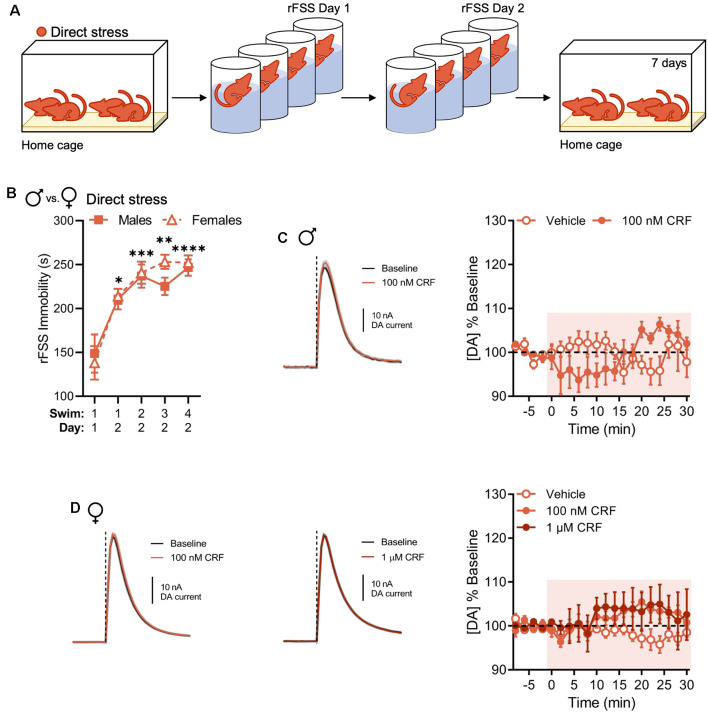
Direct stress disrupts CRF-mediated dopamine release in the NAc 1 week after repeated forced swim stress (rFSS) exposure in males and females. (A) In the direct stress experimental group, mice were exposed to rFSS and tested 7 days later. (B) Cumulative time spent immobile for the first 5 min of Swim 1 on rFSS Day 1 and Swims 1–4 on rFSS Day 2 in males (n = 6) and females (n = 10) belonging to the direct stress group. (C) Representative dopamine release evoked by electrical stimulation (dashed line) before and after application of 100 nM CRF to a NAc brain slice (mean ± SEM for five consecutive stimulations, left) and baseline-normalized mean peak amplitude of electrically evoked dopamine release over time in response to vehicle (n = 5) or 100 nM CRF (n = 5) application to NAc slices (right) from directly stressed males 1 week after stress exposure. (D) Representative dopamine release evoked by electrical stimulation before and after application of 100 nM CRF (left) or 1 μM CRF (middle) to a NAc slice (mean ± SEM for five consecutive stimulations) and baseline-normalized mean peak amplitude of electrically evoked dopamine release over time in response to vehicle (n = 5), 100 nM CRF (n = 5), or 1 μM CRF (n = 5) application to NAc slices (right) from directly stressed females 1 week after stress exposure. Error bars, SEM. *P < 0.05, **P < 0.01, ***P < 0.001, ****P < 0.0001 vs. rFSS Swim 1 Day 1 immobility.